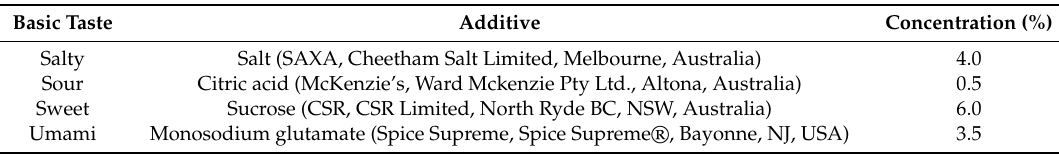
Table 1. Concentration of additives used for the production of selected chocolate samples.